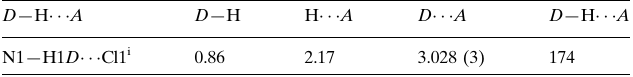
Hydrogen-bond geometry (A˚ , (cid:3)